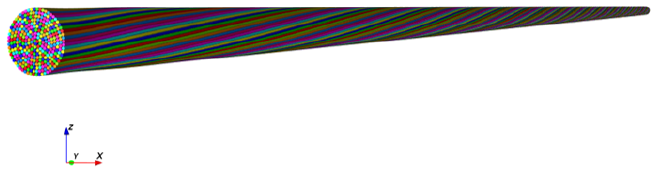
Figure 18. The full yarn